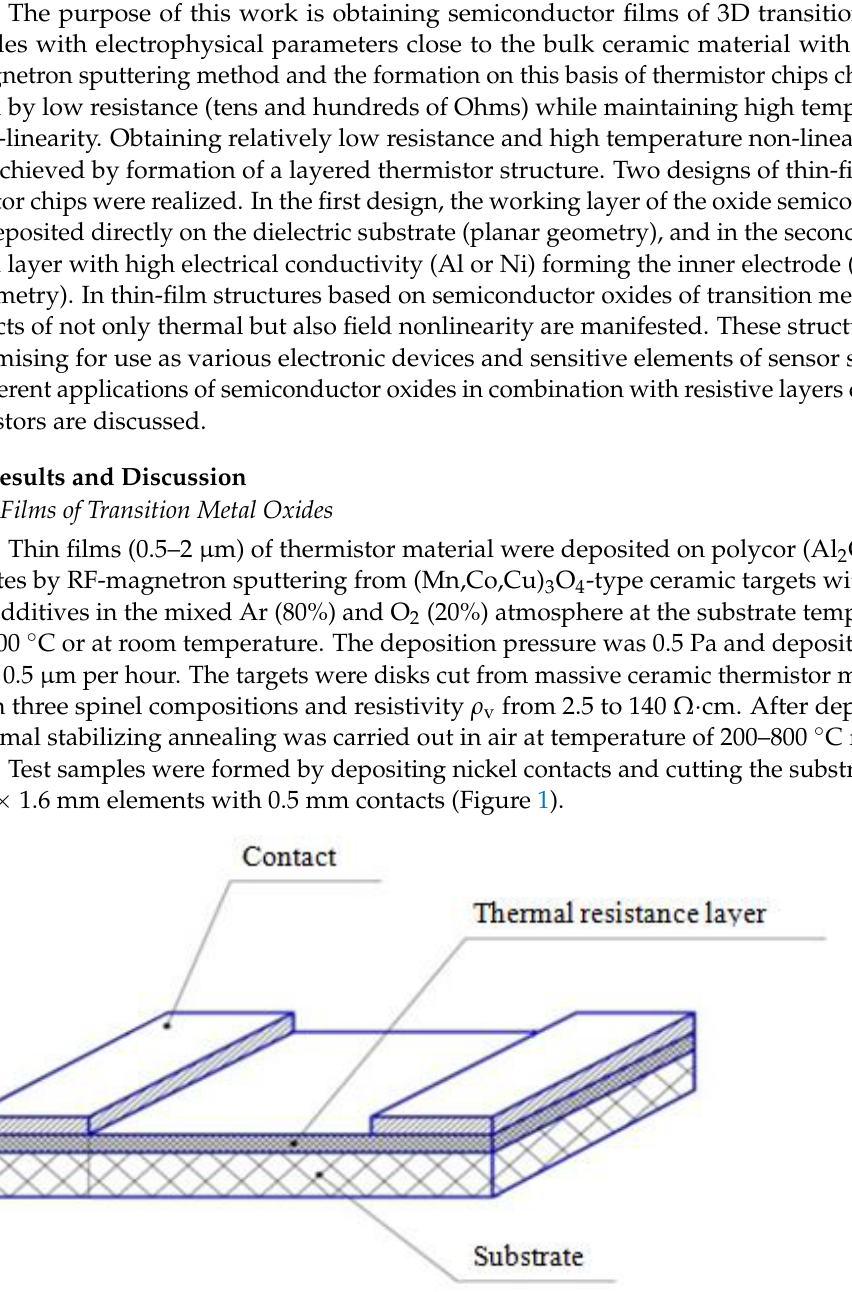
Figure 1. Schematic representation of the thin-film thermistor structure.